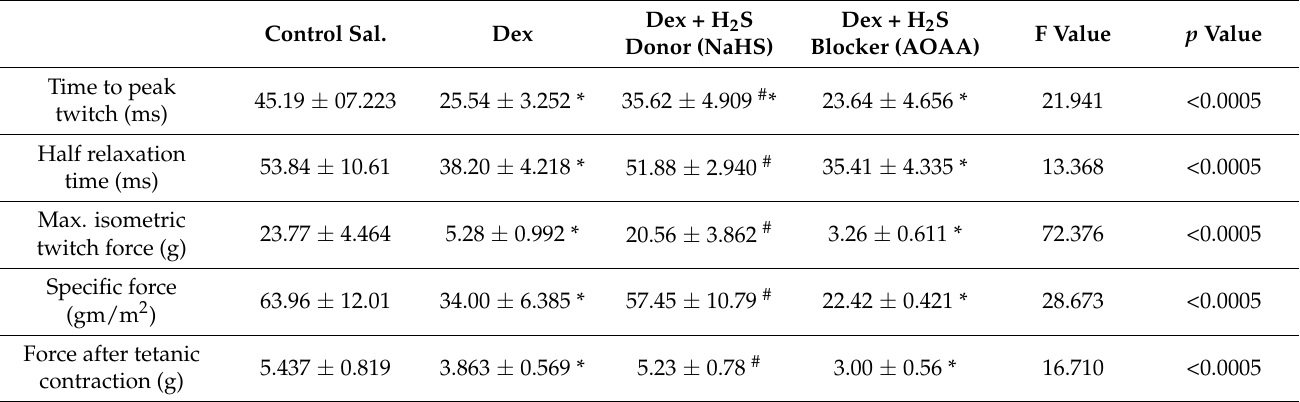
Table 5. Isometric contractile properties of the soleus